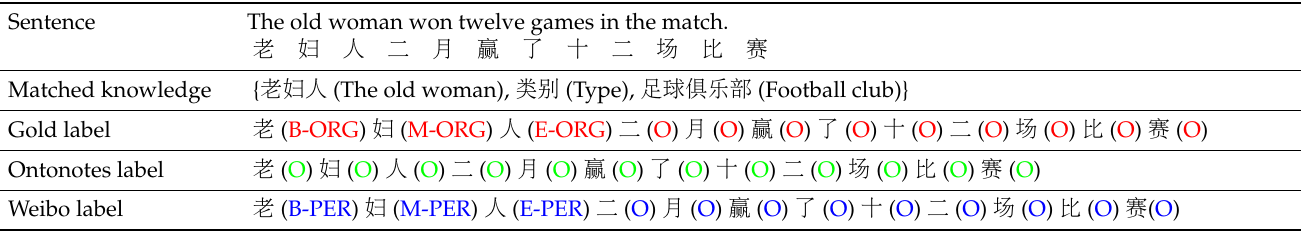
Table 6. Labeling comparison on different